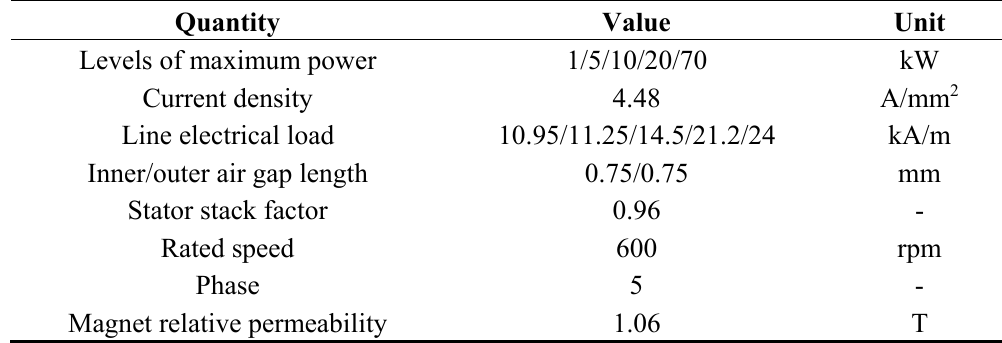
Table 1. Partial Parameters of the DRPMSM.